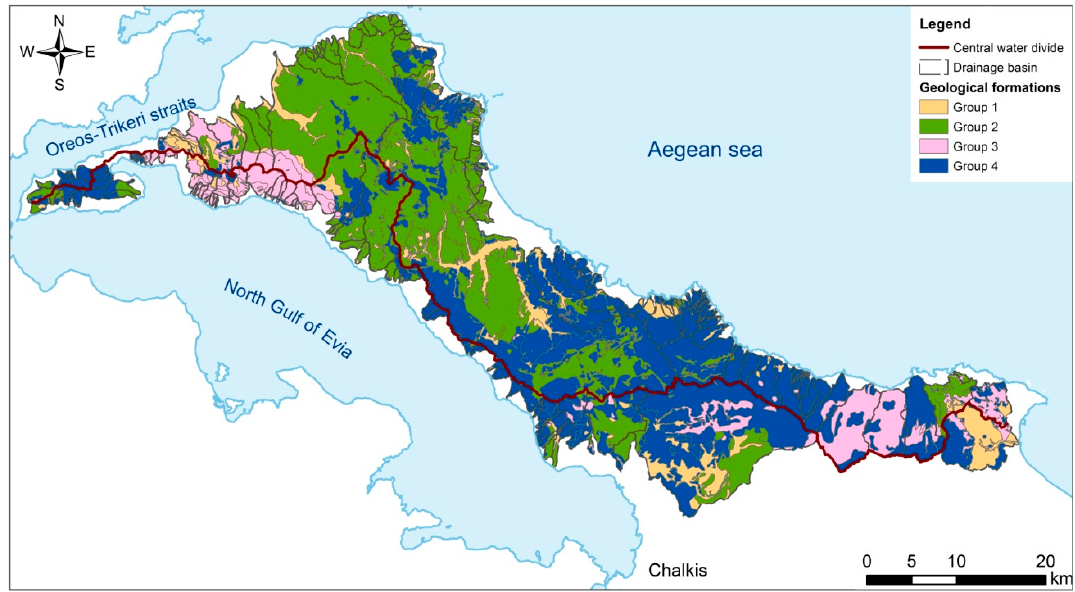
Figure 5. Simplified lithotechnical map of the study area based on the geotechnical map of Greece [33] (Group 1: surface deposits such as alluvial deposits, recent talus cones and scree and semi consolidated talus cones; Group 2: soft geological formations including marls, sandstones, schists-cherts, and travertines; Group 3: formations of medium resistance consisting of schists and phyllites; and, Group 4: very resistant, hard to erode, formations, including limestone, dolomites, greywackes, consolidated conglomerates, ophiolites, peridotites, and quartzites).